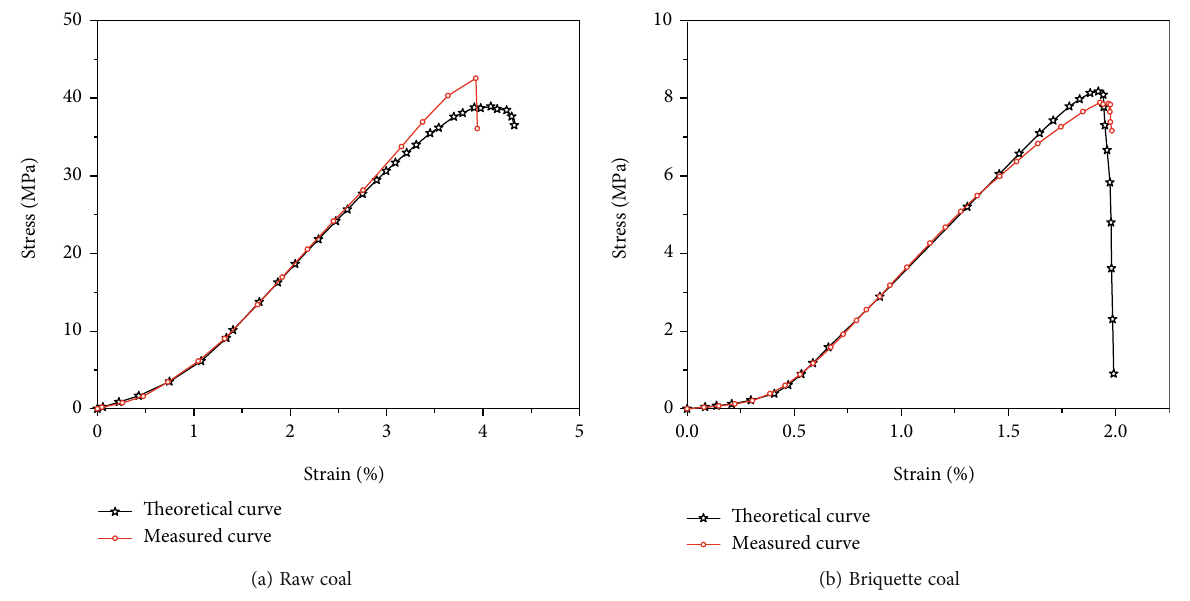
Figure 8: Comparison between experimental and theoretical stress-strain curves of raw coal and briquette coal. Table 1: Fitting parameters of theoretical